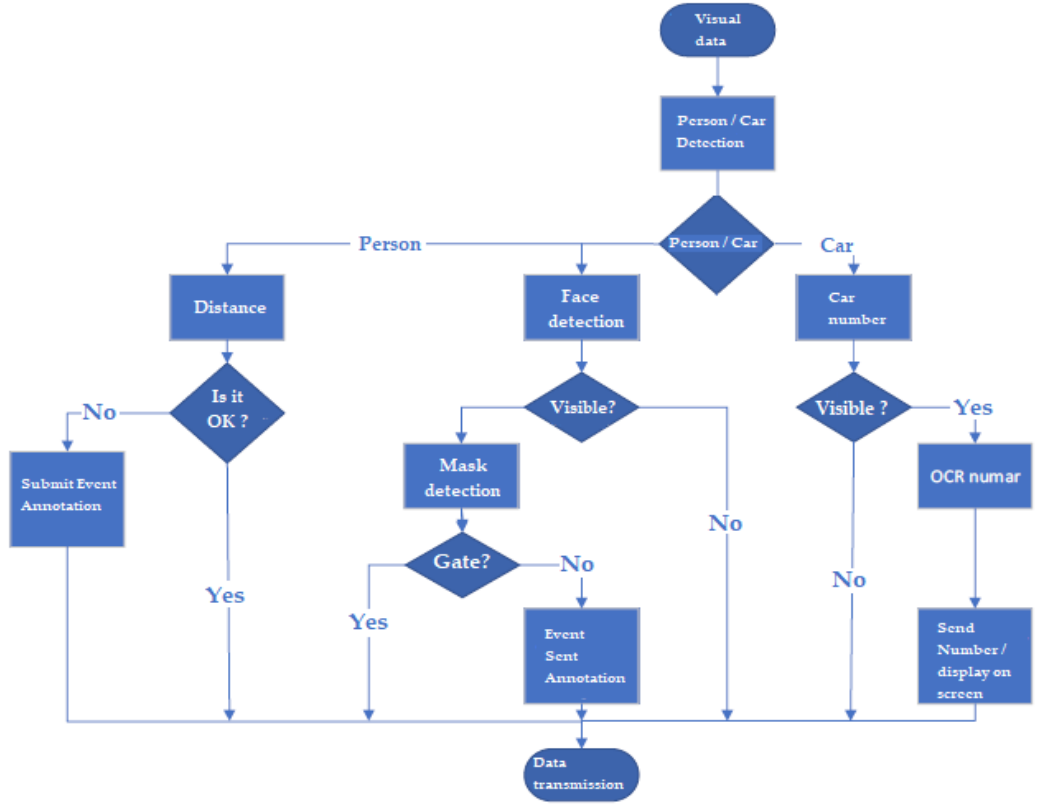
Figure 4. Operational algorithm of 19 Sol/UAV.